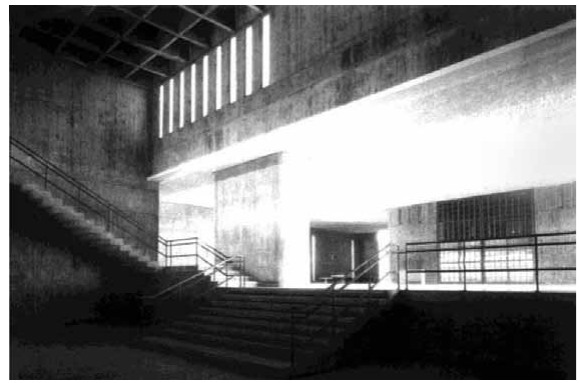
fig. 10. M.E.T.u faculty of architecture, ankara (Improvisation/Mimarlıkta Doğaçlama ve Behruz